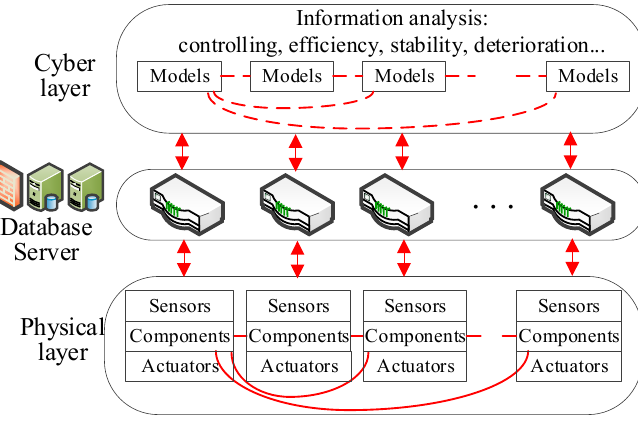
Figure 1. The generic structure of cyber physical system for the application of thermal power plants.